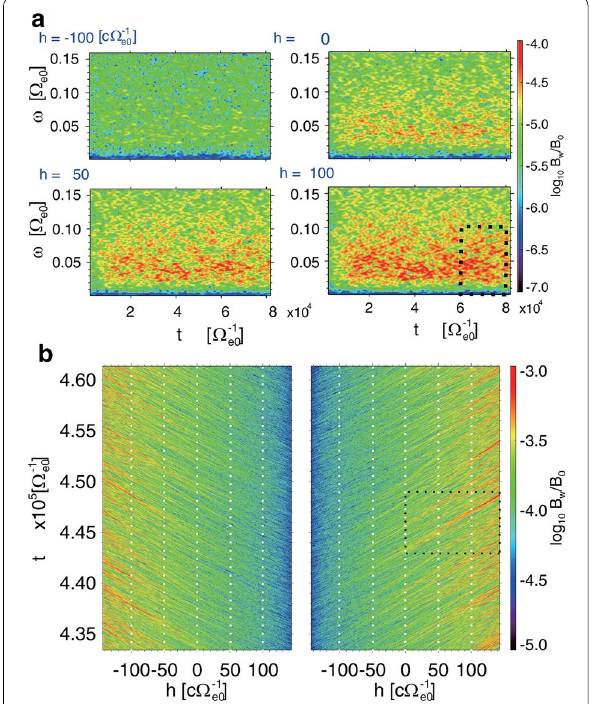
Fig. 11 Particle simulation of hiss emissions. a Dynamics frequency spectra of waves propagating forward in the direction of the magnetic field at positions h 100, 0, 50, 100 c (cid:31) − 1 e0 at the initial = − 0 8 10 4 (cid:31) − 1 e0 ). The equator is phase of the simulation ( t = ∼ × 0 . b Spatial and temporal evolution of transverse wave at h = 0.5 , and amplitudes B w of waves propagating forward (right panel) and = backward (left panel) along the magnetic field line for an short time 4.35 4.60 10 5 (cid:31) − 1 e0 (after Hikishima et al. interval t = ∼ ×